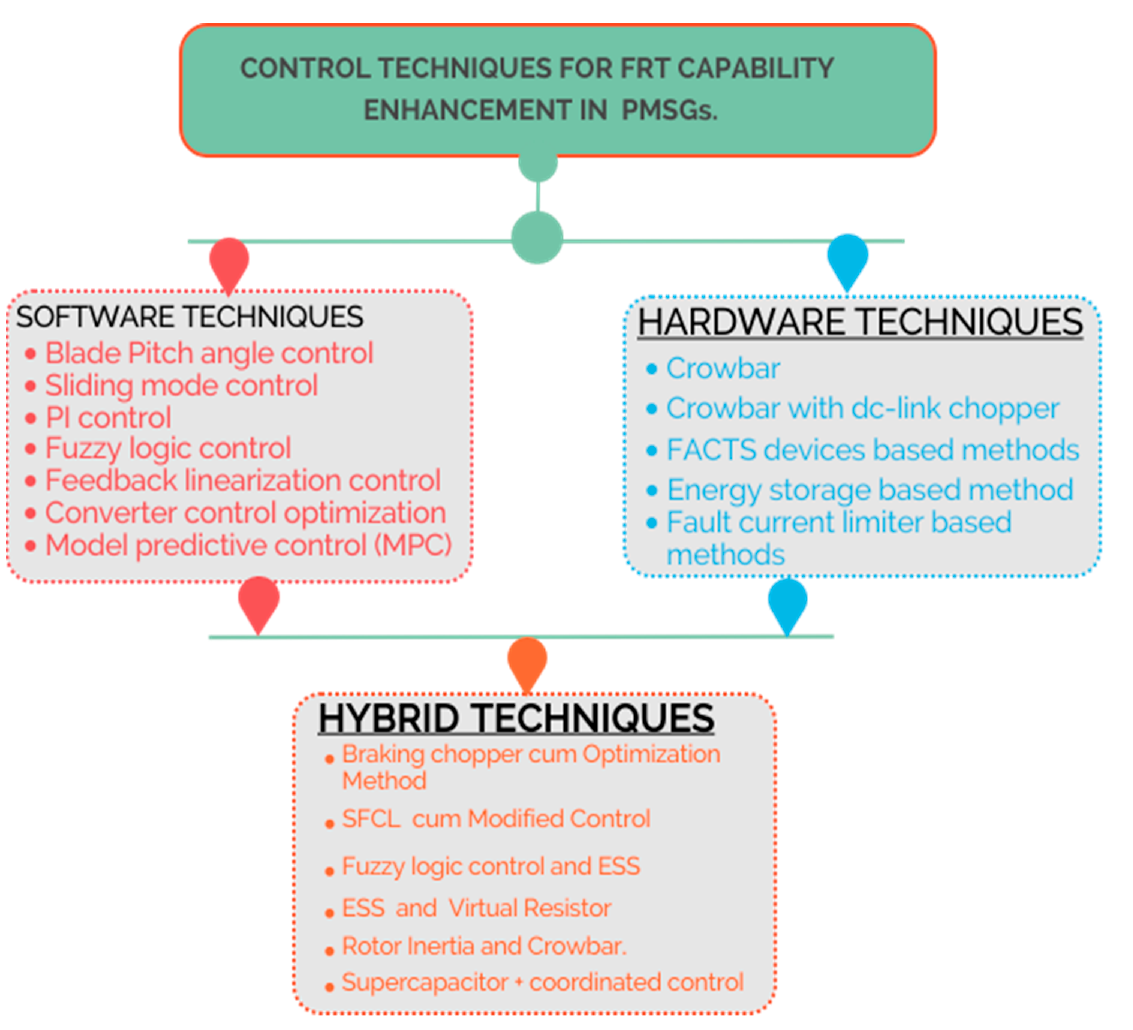
Figure 13. Classification of FRT techniques for PMSG.